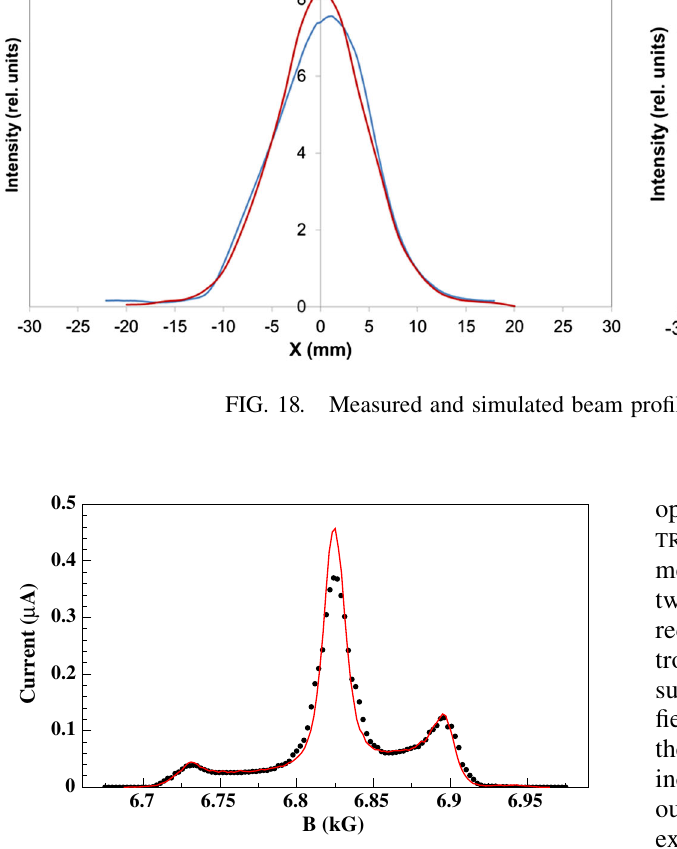
FIG. 19. Measured (dots) and simulated (red curve) beam intensity as a function of the magnetic